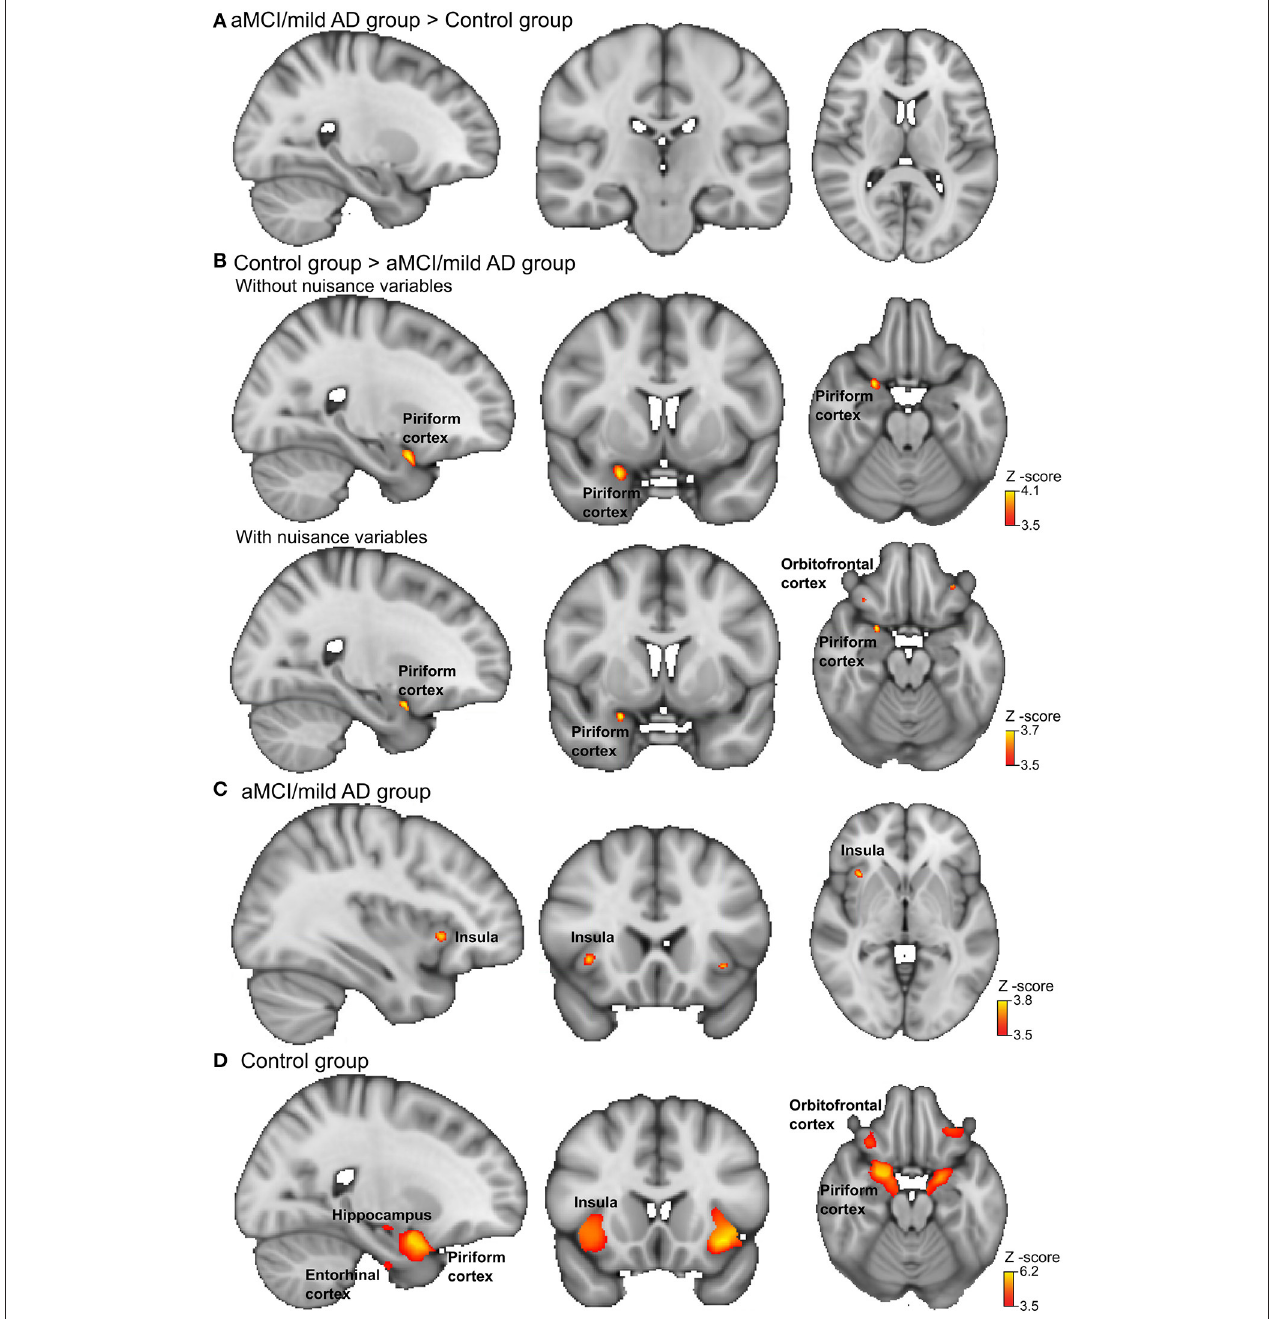
FIGURE 2 | Brain activation during odor identification for amnestic mild cognitive impairment (aMCI)/Alzheimer’s dementia of mild degree (mAD) patients and controls. Voxels in the olfactory cortices that showed increased activation during passive smelling for (A) aMCI/mAD patients > Controls, (B) Controls > aMCI/mAD patients, aMCI/mAD patients in upper row and with the nuisance variables age, sex, education, and brain parenchymal fraction in the lower row. (C) aMCI/mAD group and (D) Control group. The analysis was carried out using an olfactory network region of interest mask and a corrected cluster threshold of p = 0.05 (see section Materials and Methods). The “x = ” in the lower left corner of each brain image indicates the position in the Montreal Neurological Institute (MNI) space. For more details on activation locations, see Table 4 ; for associations with olfactory test scores and cognition, see Table 5 .